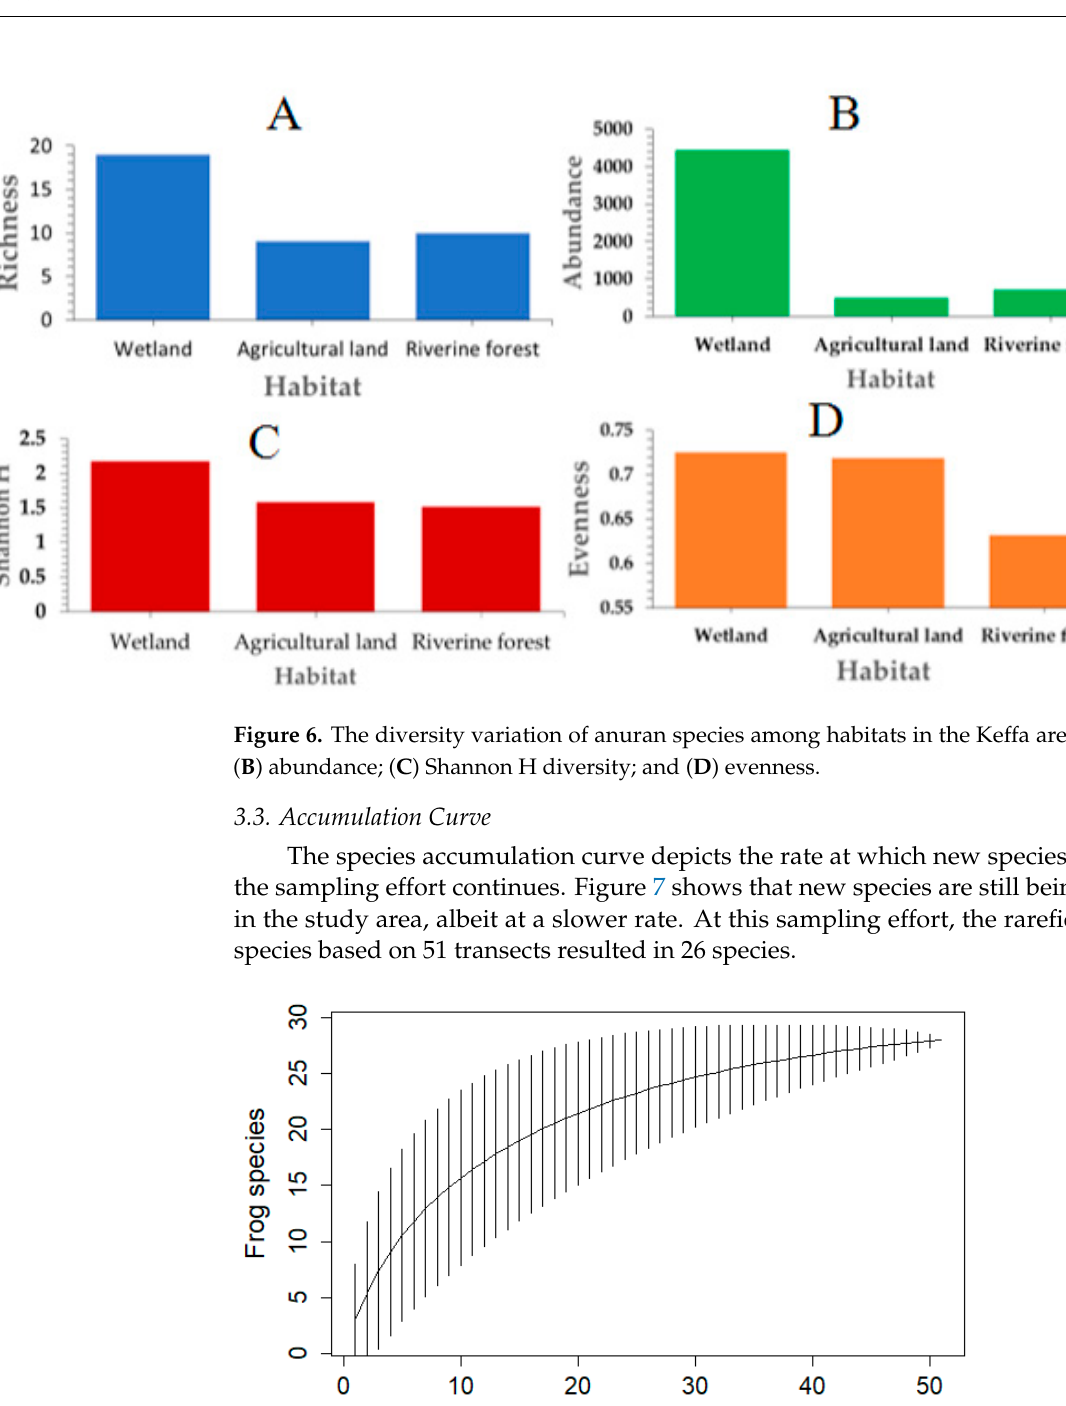
Figure 8. Comparison of the diversity of anuran species in three habitat types in the Keffa area through rarefaction solid lines and extrapolation dotted lines based on the number of individuals of the frog species. Species diversity was estimated using Hill numbers: q = 0 (frog species richness), q = 1 (exponential of Shannon’s entropy index) and q = 2 (inverse of Simpson’s concentration index). 3.5. Similarity Indices of Frog Species between Habitats Species similarity analysis between paired agricultural land and riverine forest hab- itats, agricultural land and wetland as well as riverine forest vs. wetland habitats showed SCSI and JCSI values of less than 0.50 representing 40%, 34% and 39% of species similarity by SCSI and 25%, 21% and 24% by JCSI, respectively (Table 4).